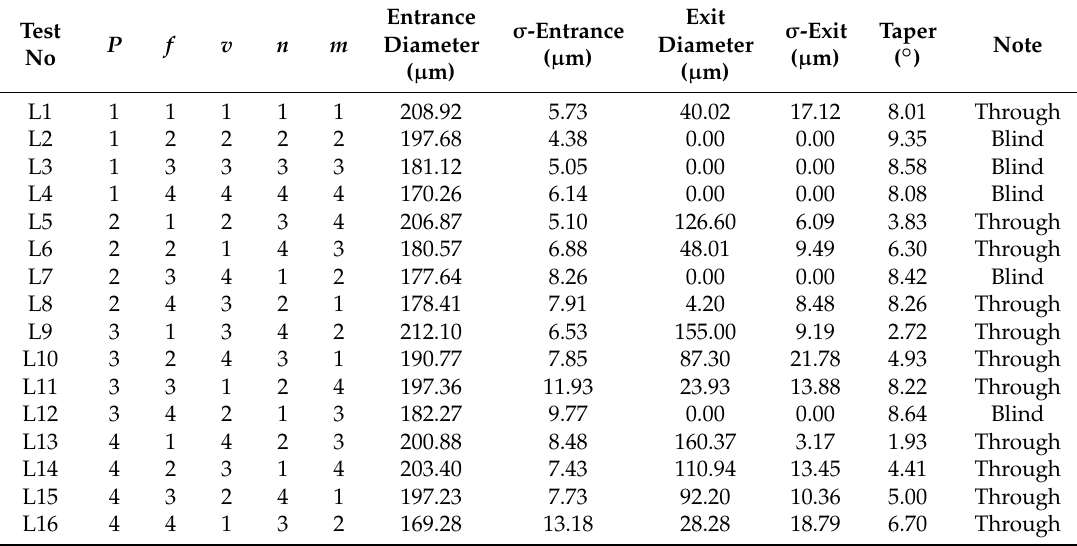
Table 3. Summary of laser direct trepanning